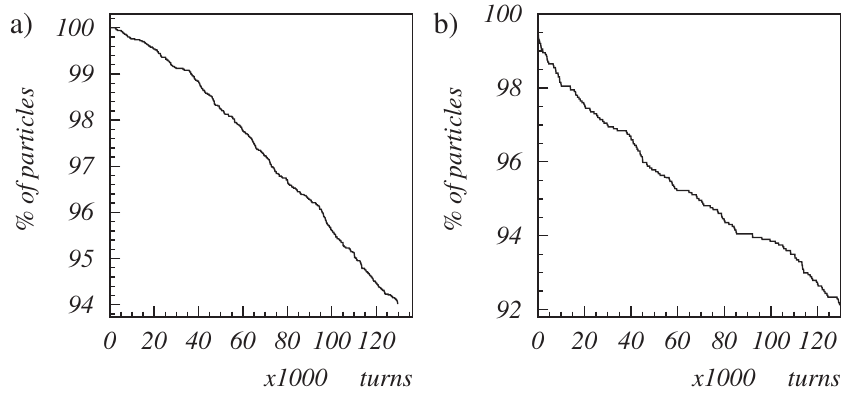
FIG. 12. SIS100 beam loss with space charge for beam 1 (left) and beam 2 (right) for an intensity of 3 (cid:5) 10 11 ions.